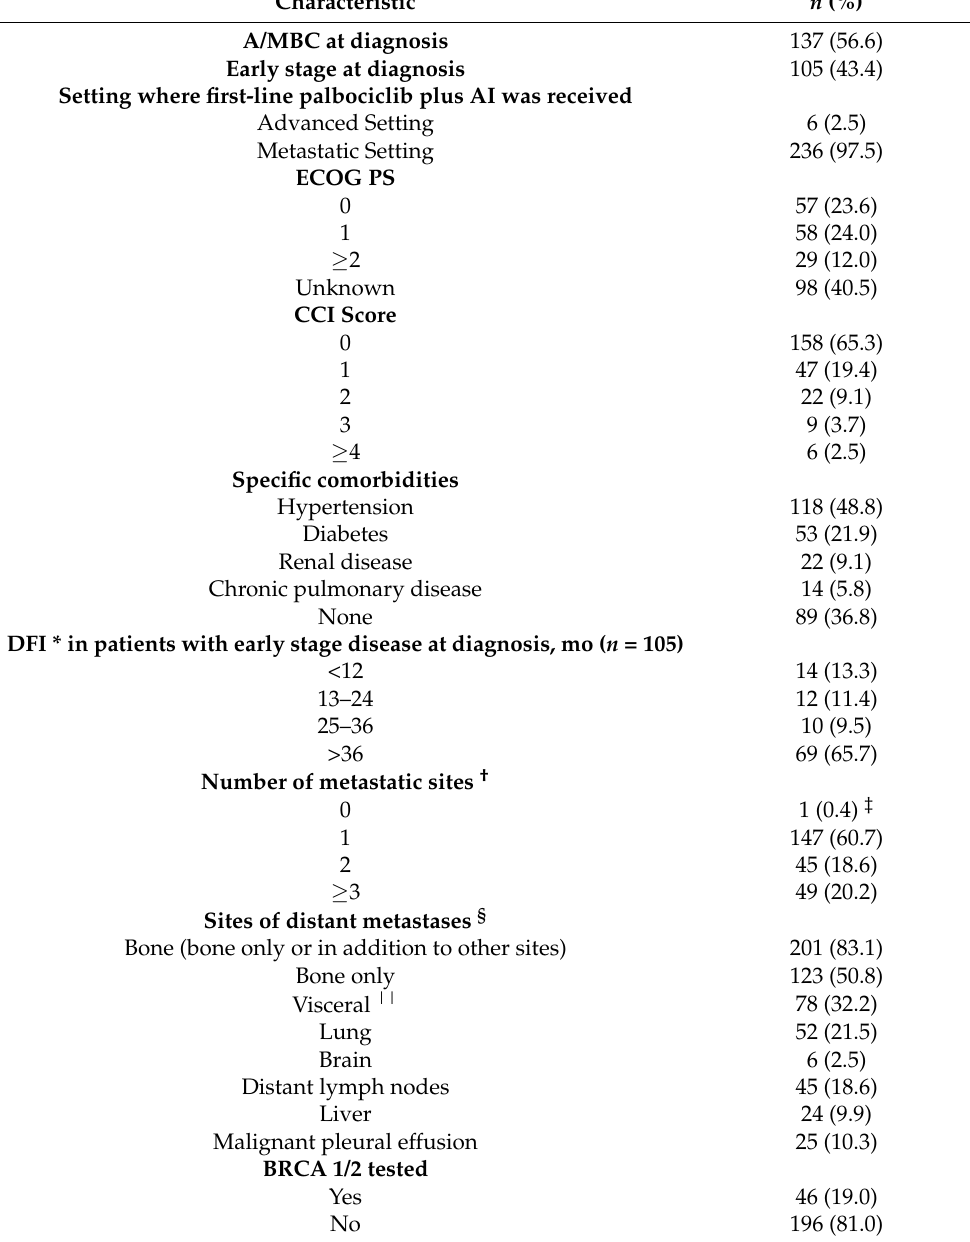
Table 2. Disease characteristics and comorbidities ( n =